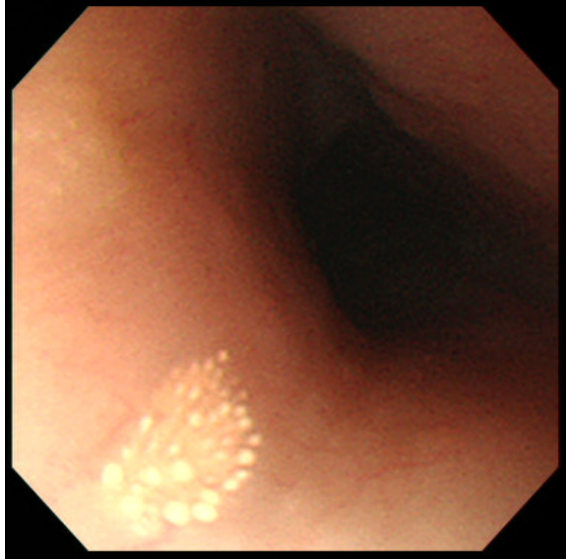
Figure 1: Endoscopic findings of esophageal xanthoma. A small yellowish granular lesion is noted in the esophageal